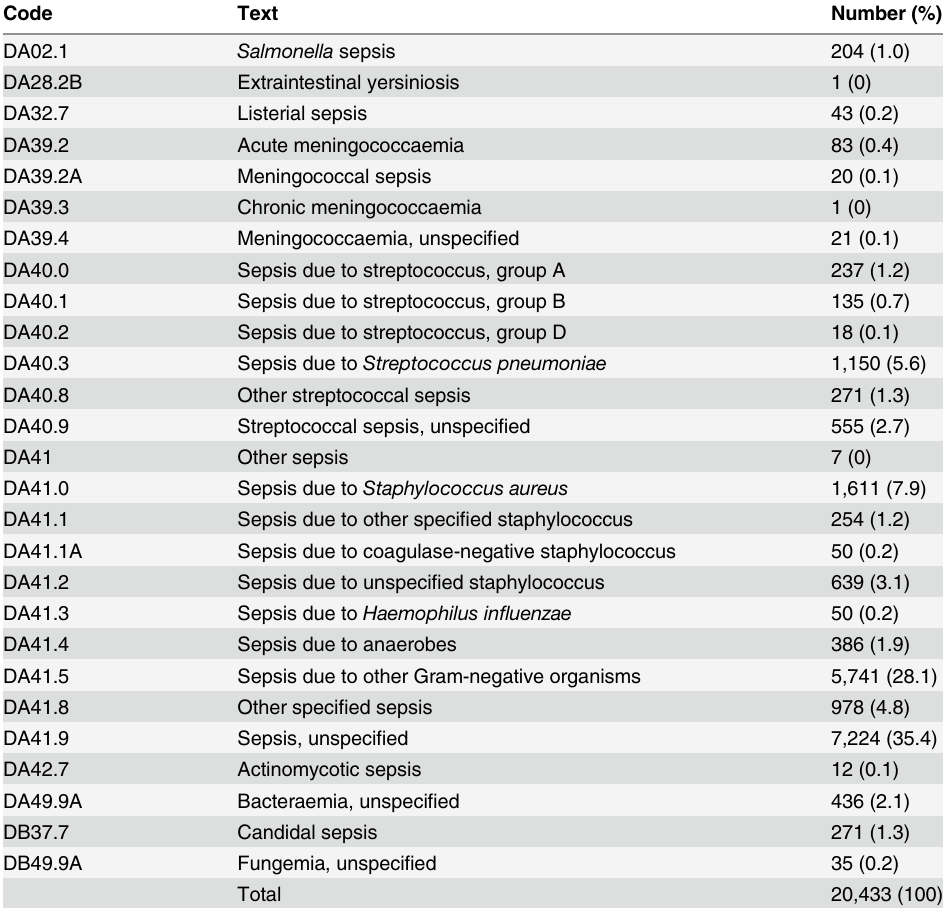
Table 2. Group 1 ( ” Infections / bacteraemia ” ) codes, which most likely represent bacteraemia, given to 18,786 bacteraemic